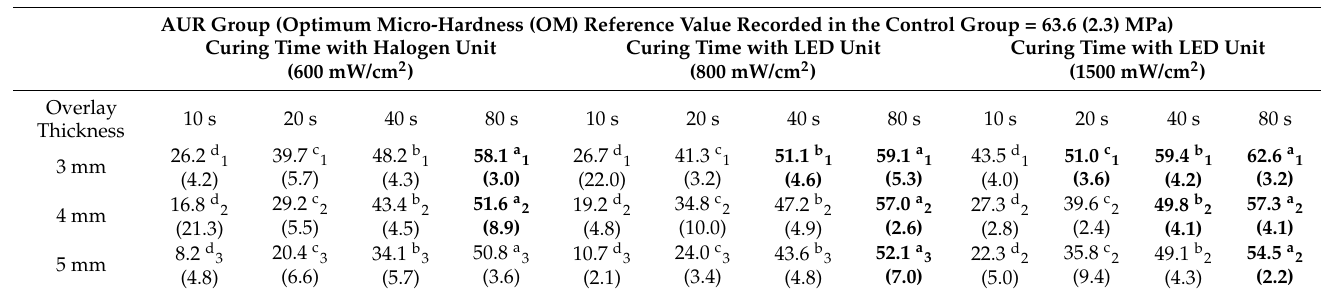
Within each different curing unit, the same superscript letters indicate no statistically significant differences among the levels of the factor “Curing Time” (reading horizontally). The same subscript numbers indicate no statistically significant differences among the levels of the factor “Overlay Thickness” (reading vertically). Numbers in bold represent mean VH values above 80% of each respective OM reference value, recorded in the heat-cured control